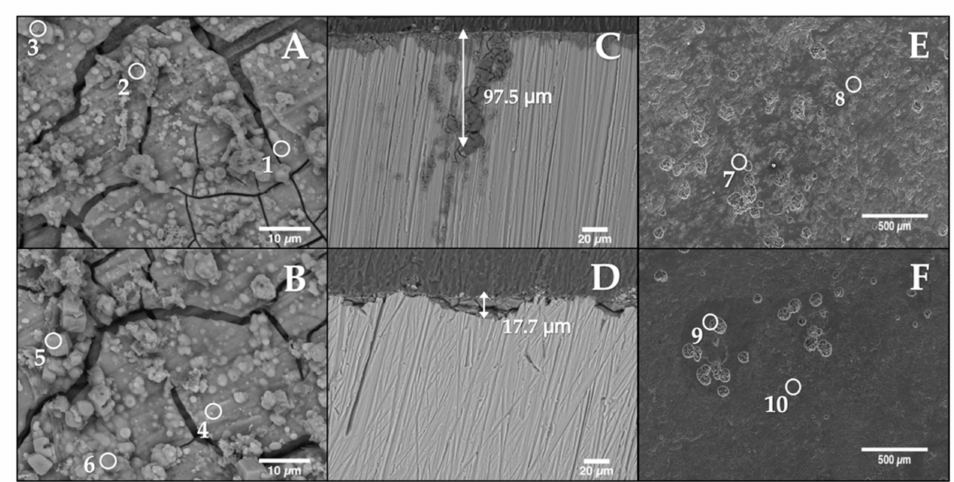
Figure 3. SEM images of the morphological surfaces changes after immersion in Hank ´ s solution for 14 days: ( A ) Mg and ( B ) Mg-Ca0.3 (2000 × ); cross-sections (500 × ): ( C ) Mg and ( D ) Mg-Ca0.3; surfaces after the removal of layers (50 × ): ( E ) Mg and ( F ) Mg-Ca0.3.